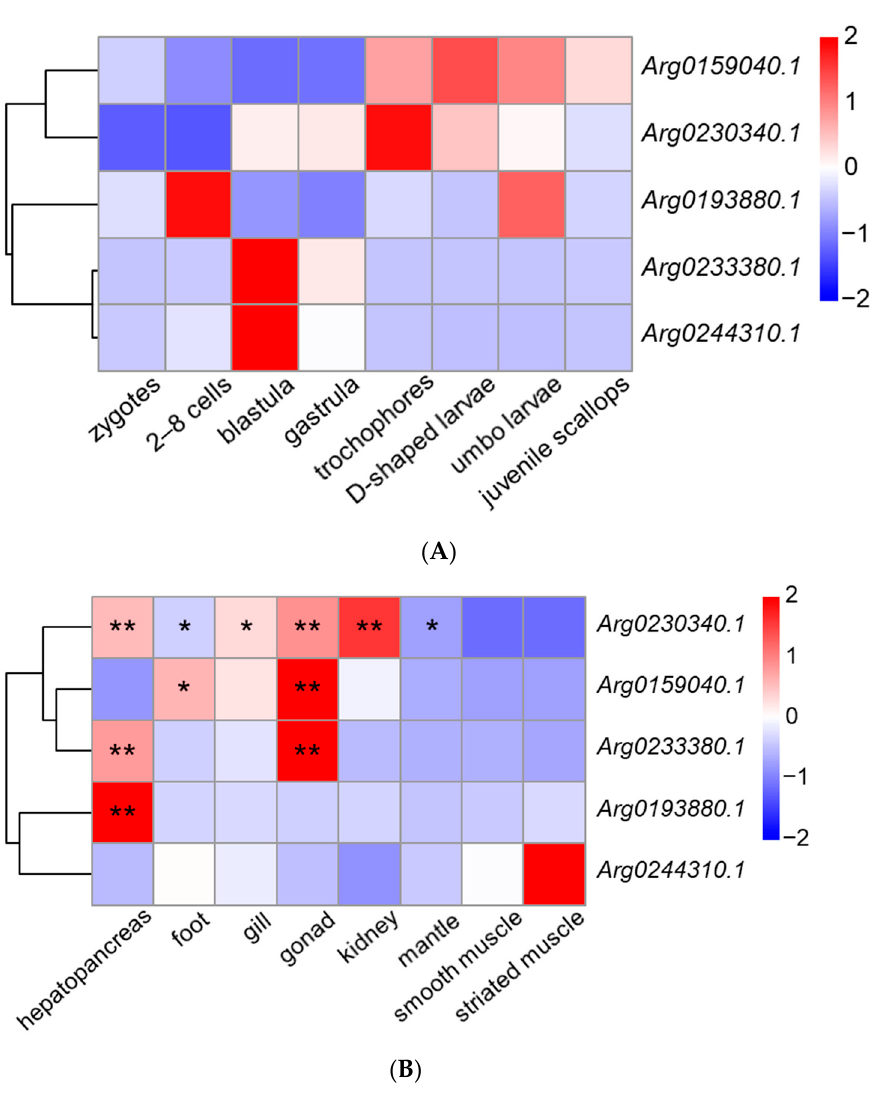
Figure 6. The expression profiles of AiPC4s from embryos/larvae at eight developmental stages and eight kinds of adult tissues have been laterally homogenized. ( A ) Relative expression levels of AiPC4s at different embryonic and larval stages. ( B ) Relative expression levels of AiPC4s in healthy adult tissues. Differently colored boxes highlight different expression patterns. Significant ( p < 0.05) and extremely significant ( p < 0.01) difference are indicated through “*” and “**”, respectively.